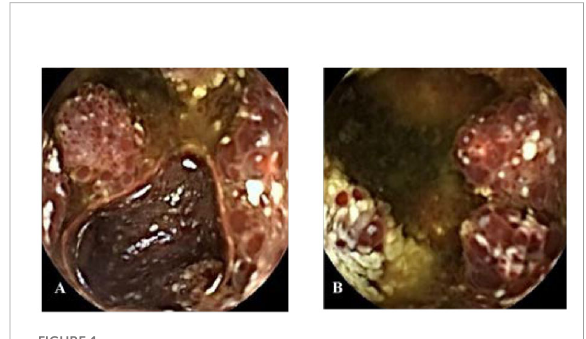
FIGURE 1 Capsule endoscopy (A, B) images of patient A. (A, B) Mucosa of the proximal jejunum showed polypoid elevation, surface hyperemia, edema, erosion, white moss attachment, and active bleeding.